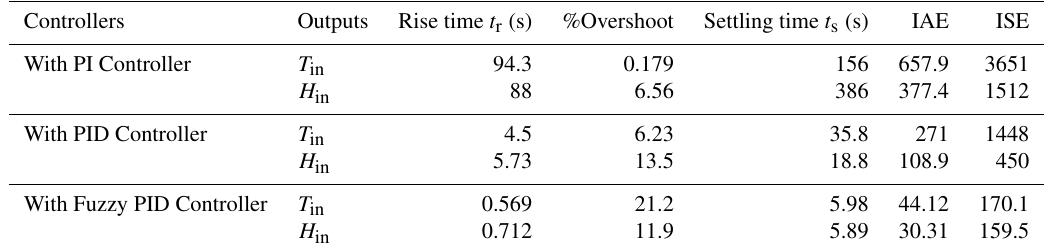
Figure 20. (a) Comparison of 15% Changes in Inlet Temperature T in Using Fuzzy PID vs. PID Controllers and (b) Comparison of 15% Changes in Inlet Humidity H in Using Fuzzy PID vs. PID Controllers Table 7. Robustness analysis of PID controller for greenhouse system.